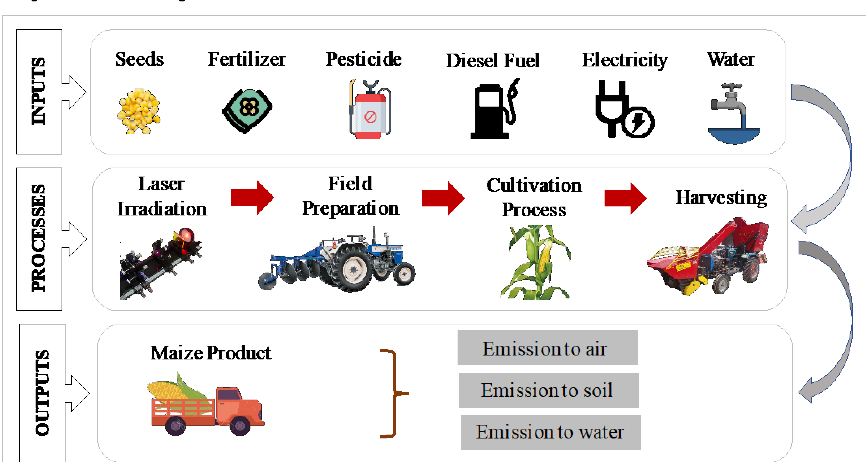
Figure 1. Flow processes of the system boundary.